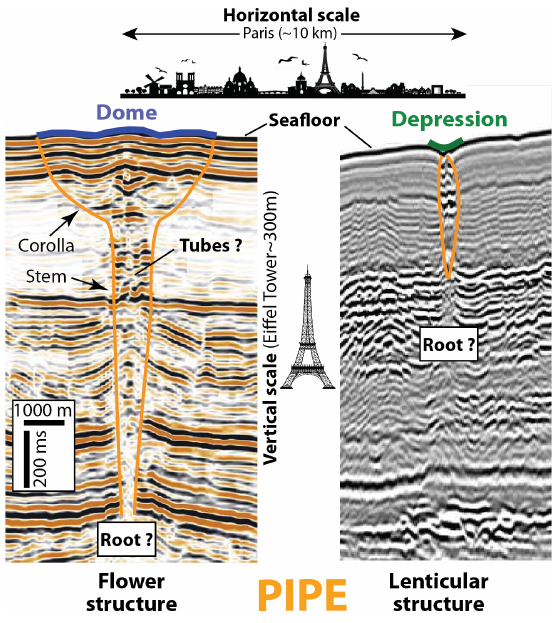
Figure 2: Seismic profiles displaying various fluid pipe structures. Left image from Dumke et al. , 2014 [36]; Gay et al. , 2012 [37]. Right image from Gay et al. , 2006 [38].